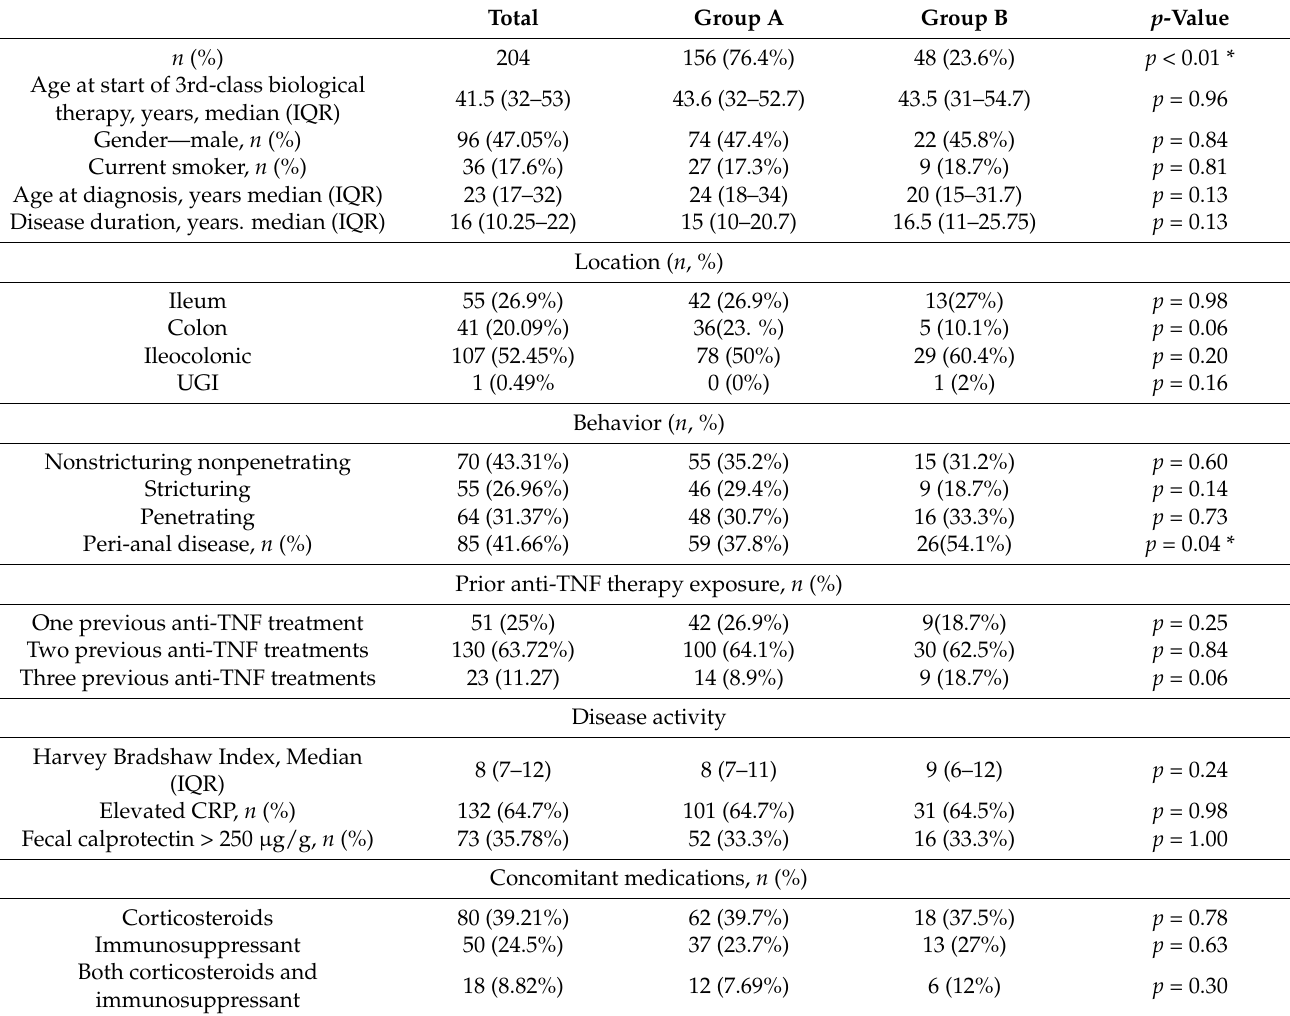
Table 1. Patients’ demographic and clinical